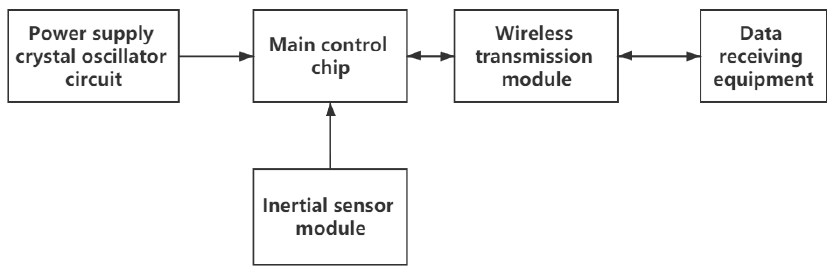
Figure 3. Data Acquisition System.